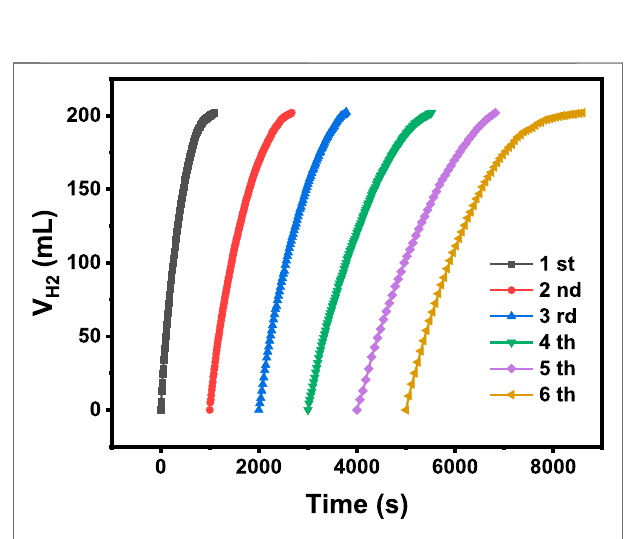
FIGURE 7 | Hydrogen evolution at different catalytic cycles when NiCo-1/CF acts as a catalyst.